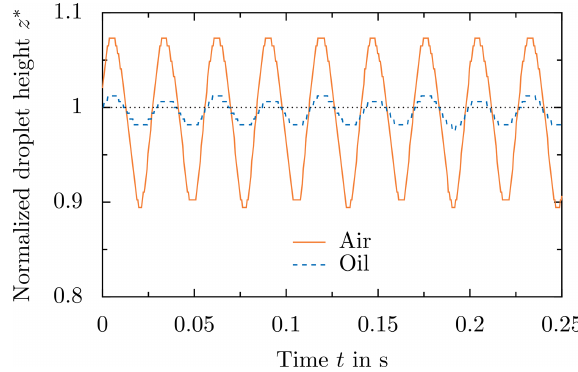
Figure 10. Comparison of droplet oscillation for different surround- ing fluids by means of the temporal variation of the normalized height of the droplet. The data correspond to the droplet shown in Fig.